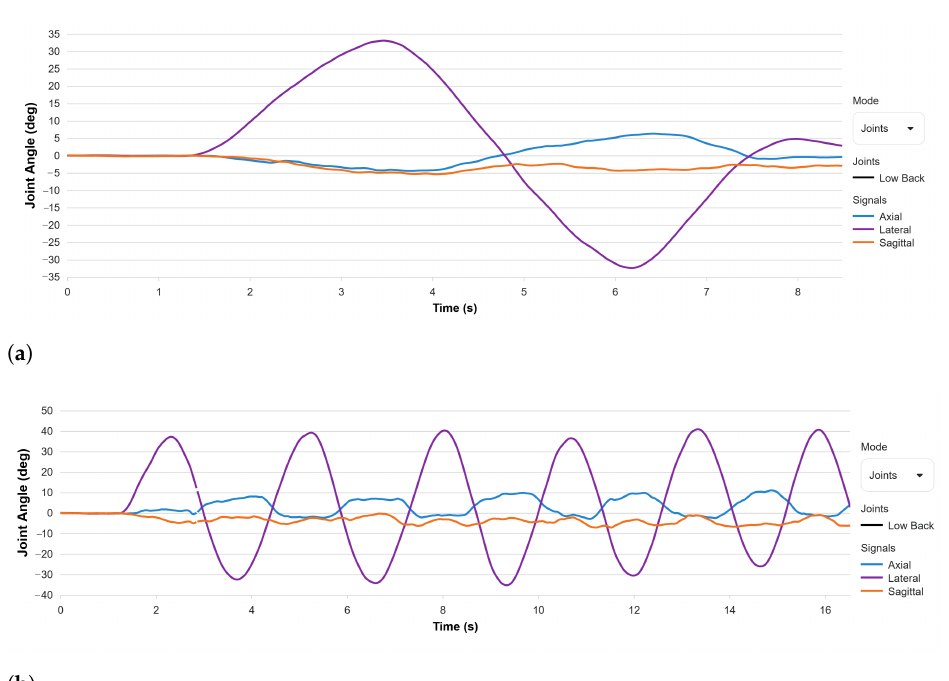
Figure A2. Samples of signals collected with the device in the three anatomical plane (Axial in blue, Lateral in purple, Sagittal in orange) ( a ) Signals in a flexibility trial. ( b ) Signals in a motion